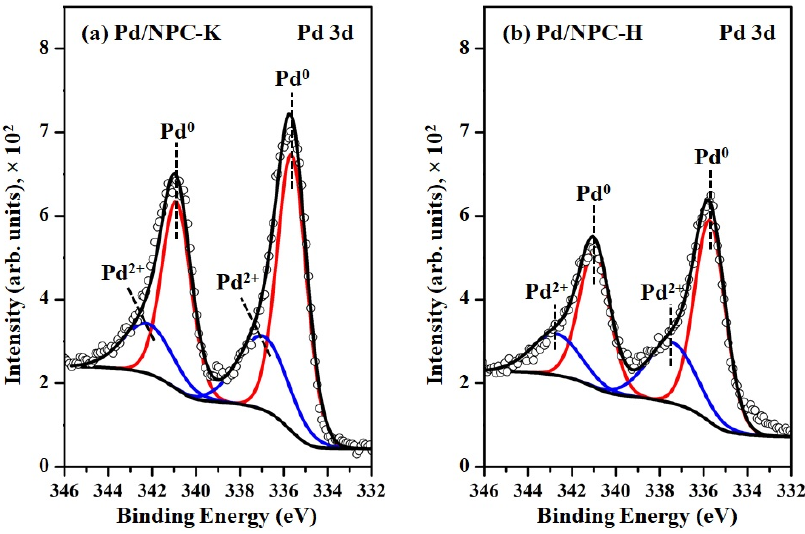
Figure 8. XPS spectra of Pd 3d in the reduced ( a ) Pd/NPC-K and ( b ) Pd/NPC-H catalysts.